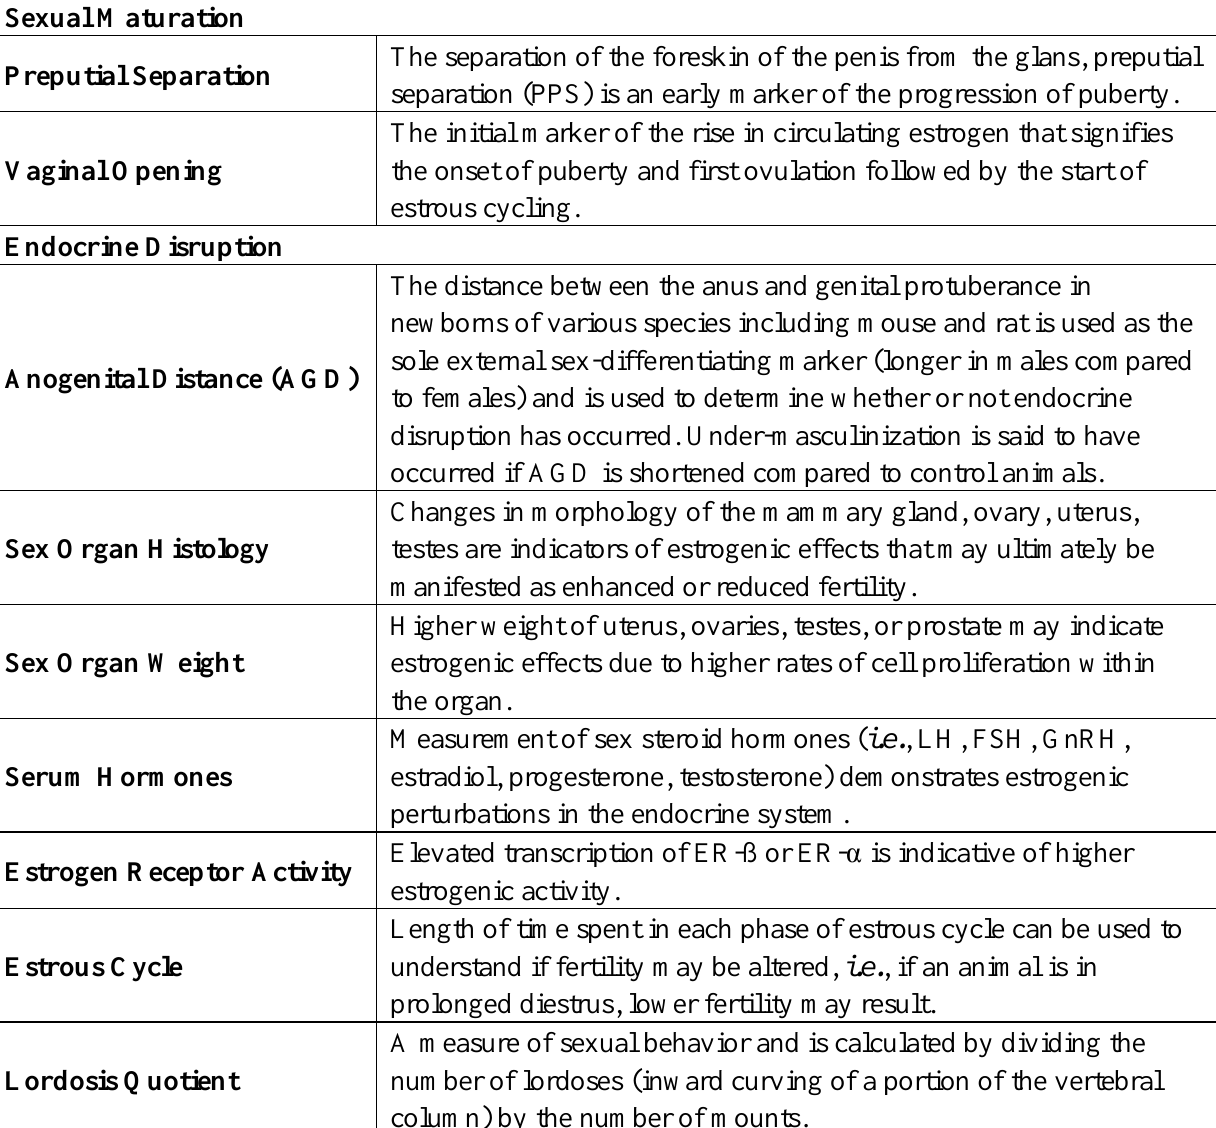
Table 2. Indicators of sexual maturation and endocrine disruption in rodent